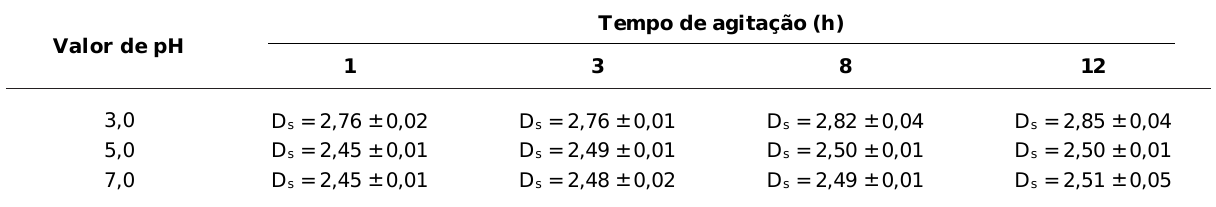
D = Dimensão fractal s